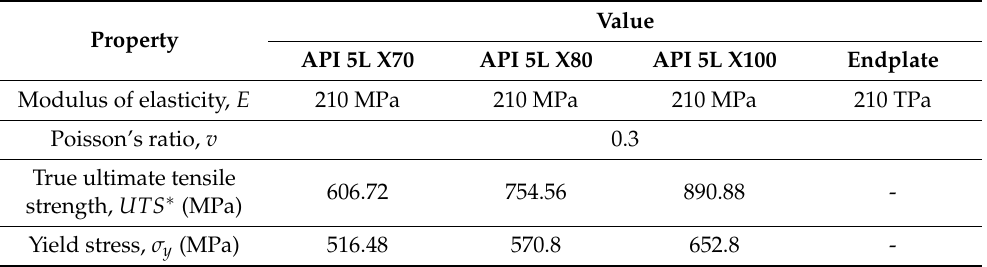
Table 2. Mechanical properties of pipe materials and endplate [2,3].